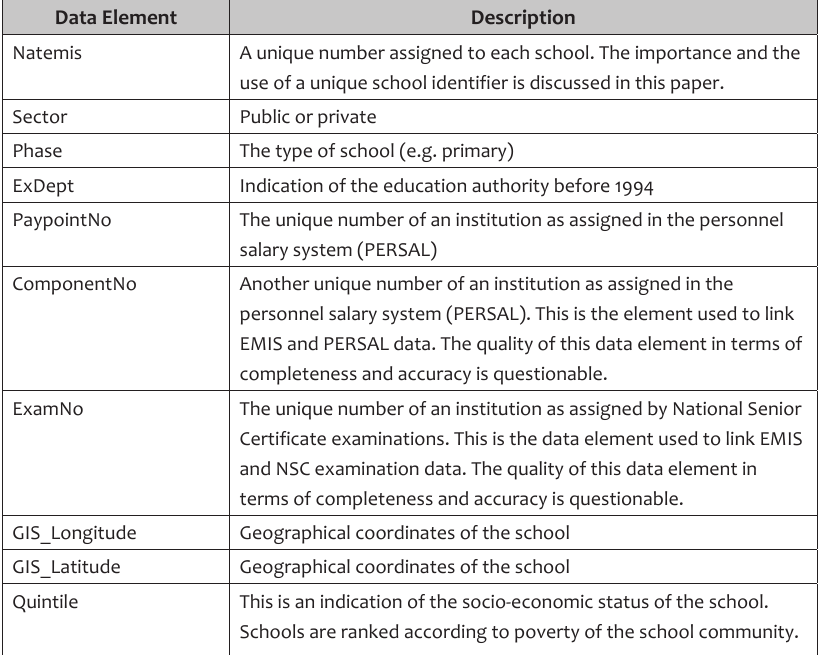
Table 1: Data elements included in the master list of schools (Source: RSA DBE 2015a) Data Element